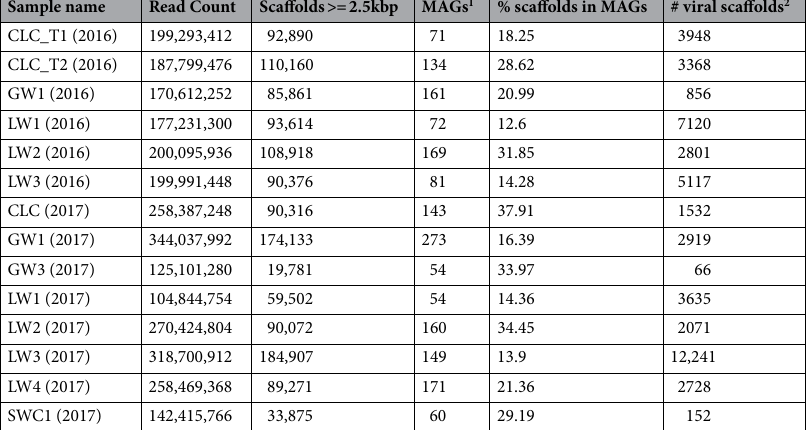
Table 1. Summary statistics for metagenomes, MAGs, and viral scaffolds from the sampling sites. 1 Quality filtered bins with > 70% completion, < 10% contamination). 2 Viral scaffolds detected from unbinned scaffolds (prior to CD-HIT